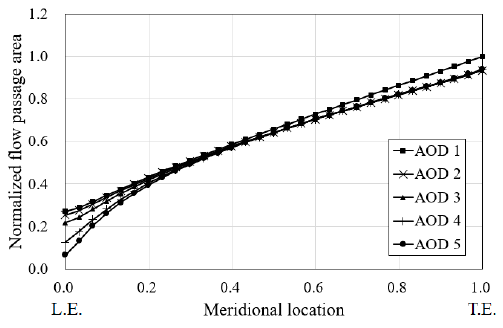
Figure 14. Flow passage area distribution in the meridional direction.